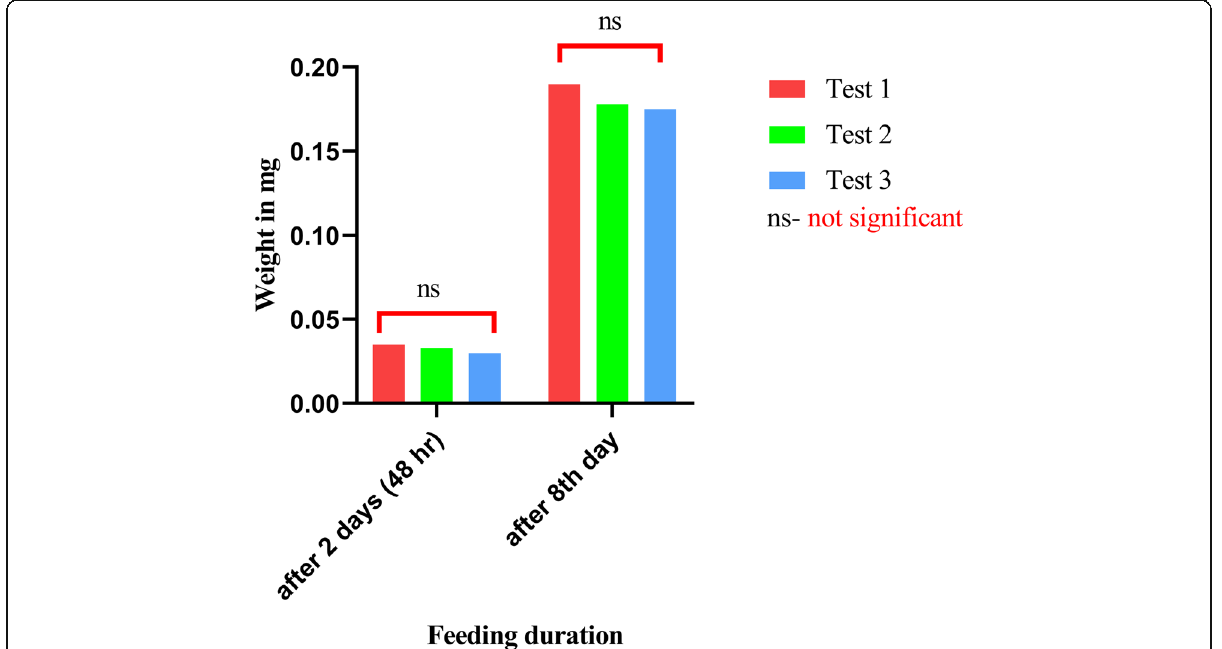
Fig. 10 Mean weight of five larvae of S. litura (third instar) fed on three different feeding preference tests and weights recorded post feeding after 2 days and on the 8th day